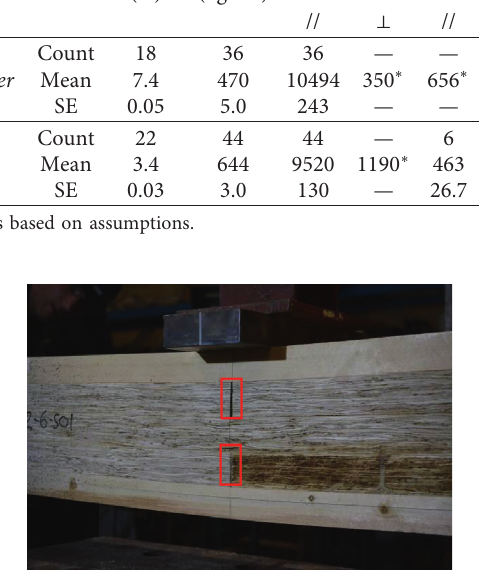
Figure 1: Butt joints in the 2 nd and 4 th layer of a 5-layer A1a